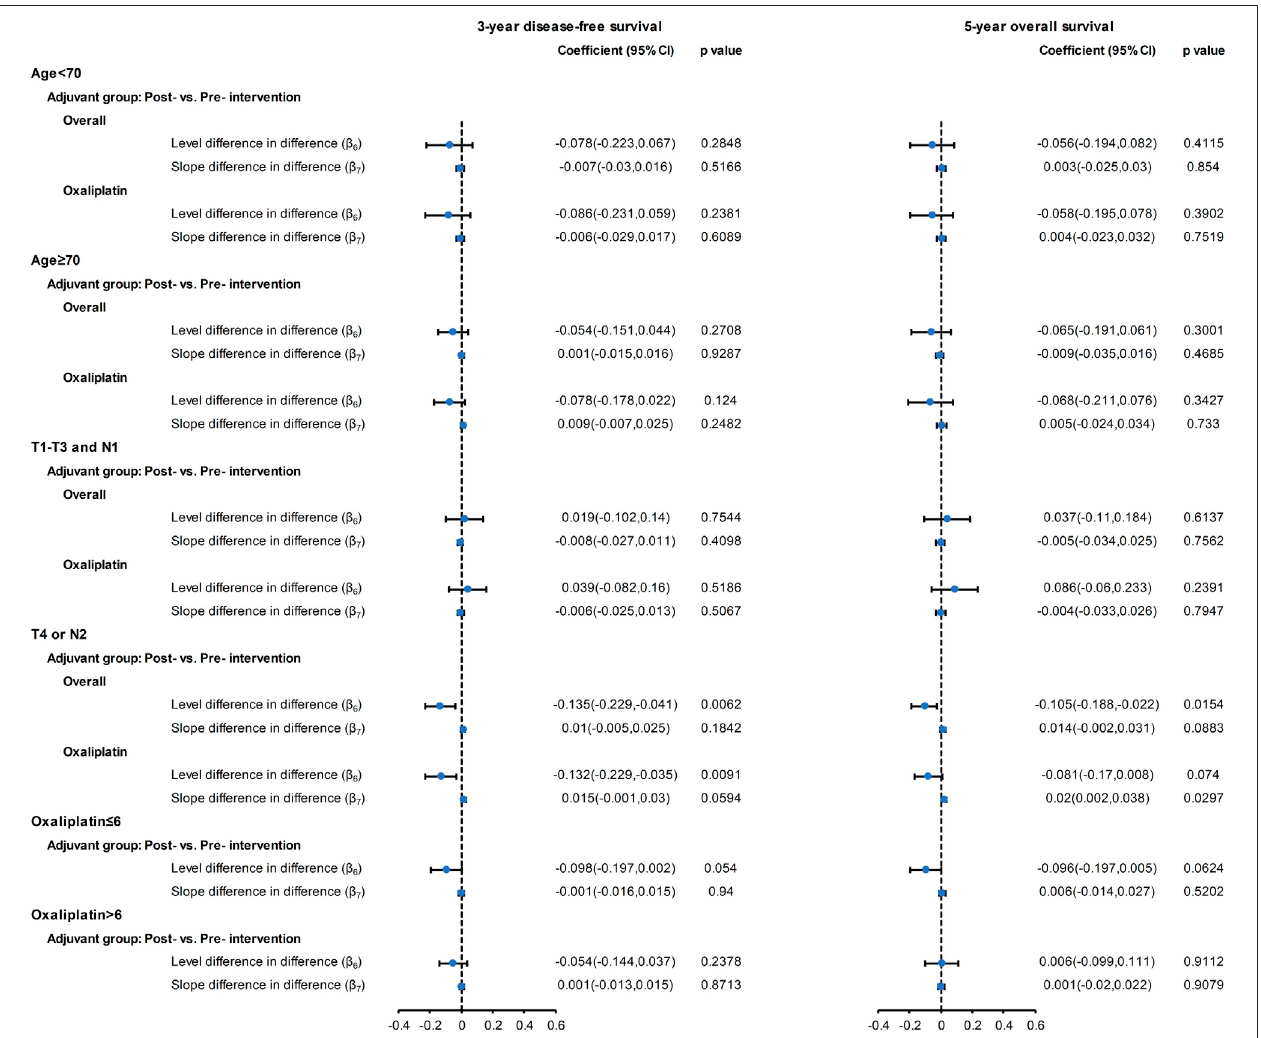
FIGURE 3 | Forest plot of the regression coef fi cients for the CITS for the overall cohort and for the oxaliplatin cohort with subgroups: aged < 70 years; aged ≥ 70 years; T1-3 and N1; T4 or N2; ≤ 6 oxaliplatin cycles; > 6 oxaliplatin cycles. Please refer to the eMethod 1 in the Supplement for the explanation of the regression coef fi cients ( β 6 , β 7